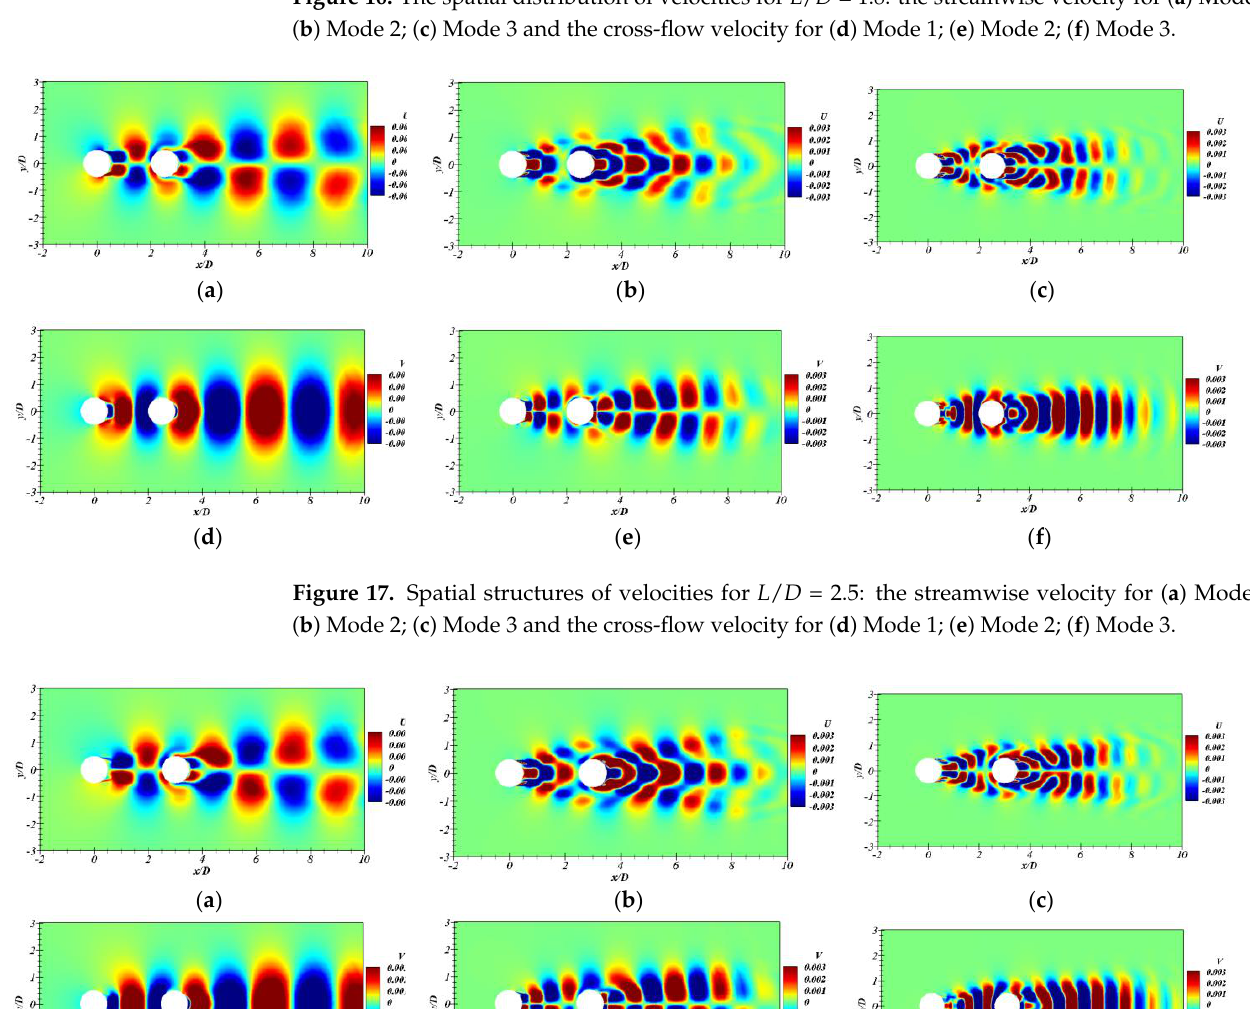
Figure 16. The spatial distribution of velocities for 𝐿/𝐷 = 1.8 : the streamwise velocity for ( a ) Mode 1; ( b ) Mode 2; ( c ) Mode 3 and the cross-flow velocity for ( d ) Mode 1; ( e ) Mode 2; ( f ) Mode 3.